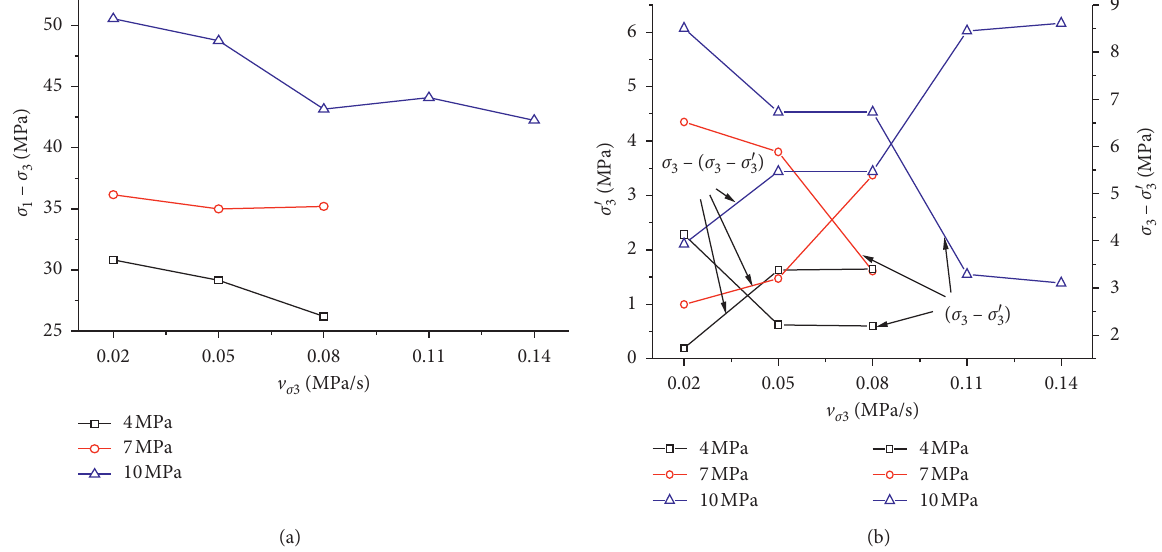
Figure 7: Coal samples under different rates of confining pressure unloading. (a) Major stress difference. (b) Confining pressure and confining pressure difference during failure.